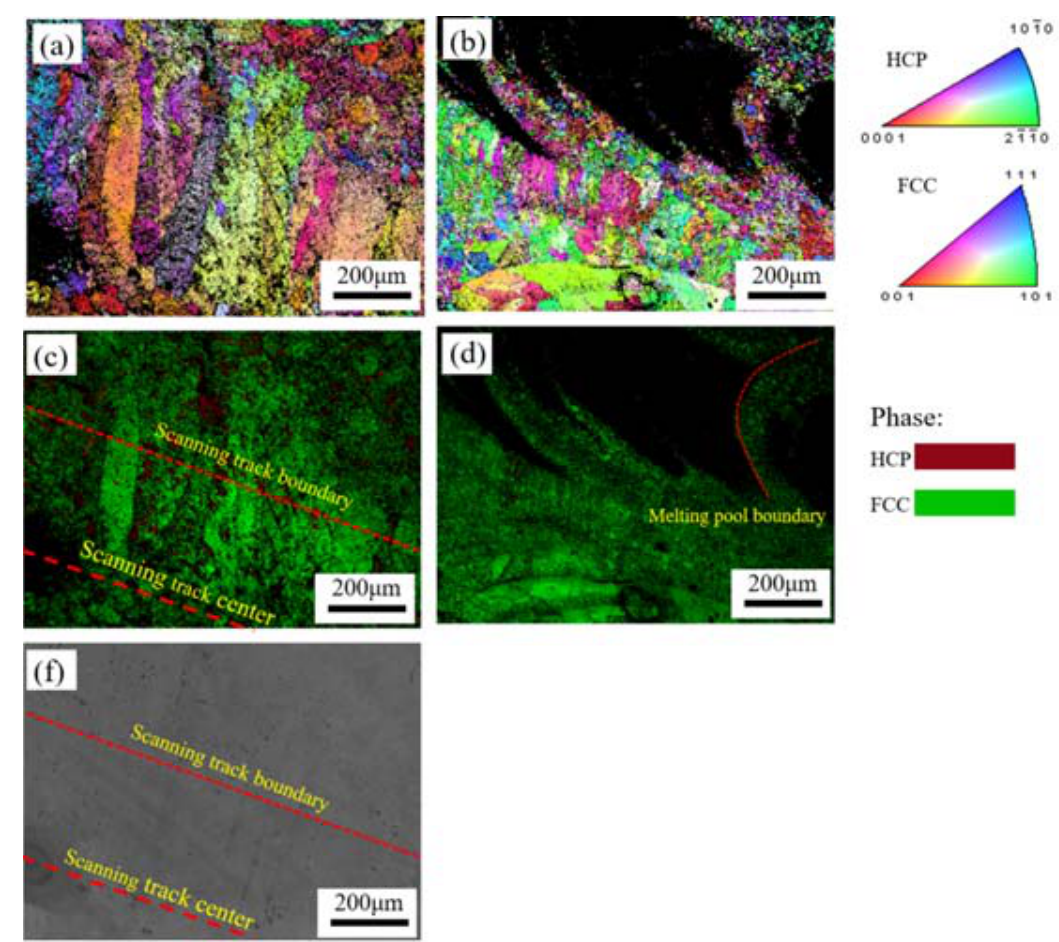
Figure 9. EBSD inverse pole figures (IPFs), IQ + phase maps and SEM image of the LMD HEA after electrochemical tests: ( a , c , f ) XY ‐ plane and ( b , d ) YZ ‐ plane.